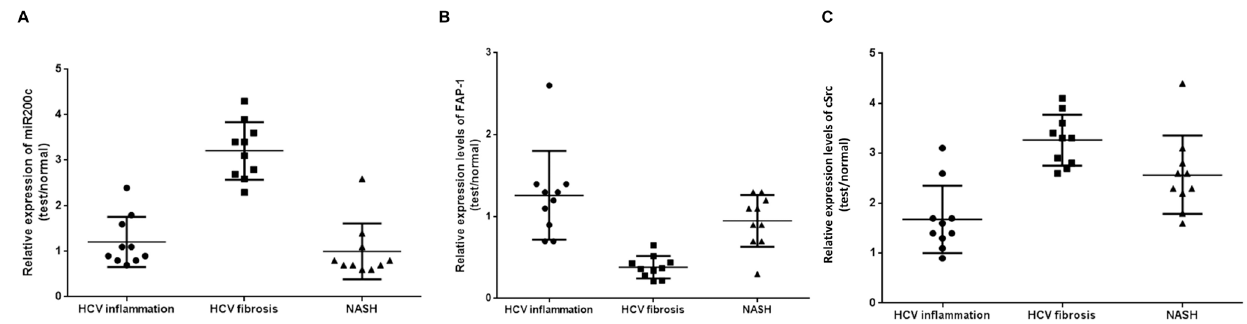
Figure 7. Modulation of growth factor signaling cascade in chronic HCV infection. Liver biopsies were obtained from 10 HCV infected patients with inflammation but no fibrosis, 10 HCV infected patients with grade III/IV fibrosis and 10 patients with NASH. Expression levels of: a) mIR200c; b) FAP-1 and c) cSrc were analyzed by quantitative RT-PCR using pre-developed Taqman miRNA assays. The small RNA U6b was used as an endogenous control and relative miRNA quantity was calculated by the DD Ct method. The horizontal line represents the average and standard deviation of fold expression levels in the groups.